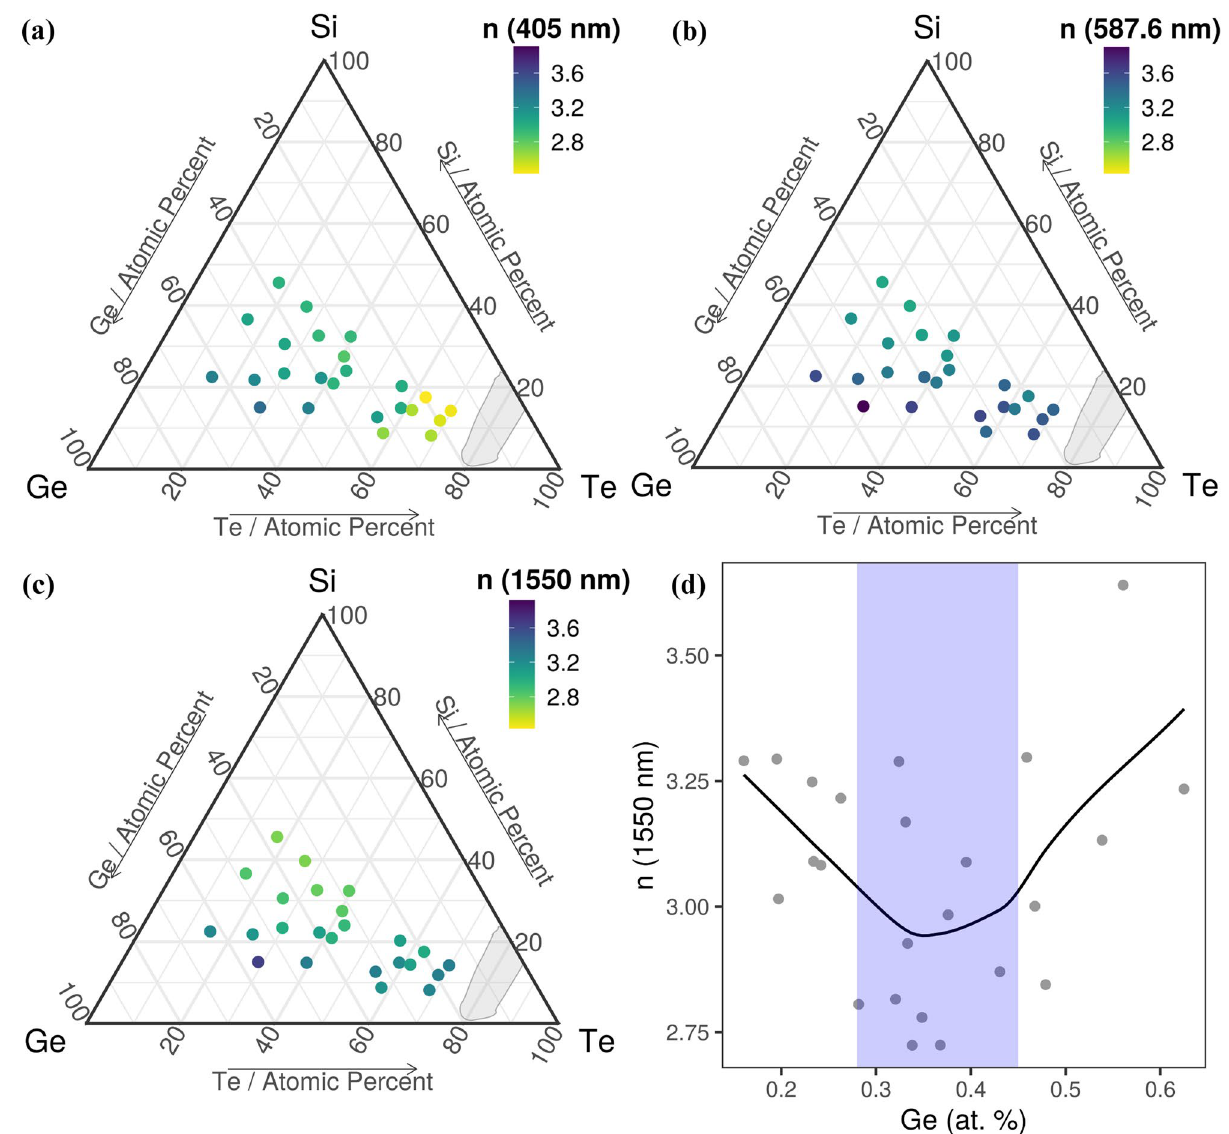
Figure 6. The refractive index at different wavelengths: ( a ) 405 nm; ( b ) 587.6 nm; ( c ) 1550 nm and ( d ) The variation of the near-IR refractive index as a function of Ge concentration. The black line and blue shaded area in ( d ) are guides to the eye. Ternary diagrams were generated with the R software [v. 3.6.3] (R: A language and environment for statistical computing, R Core Team, R Foundation for Statistical Computing, Vienna,